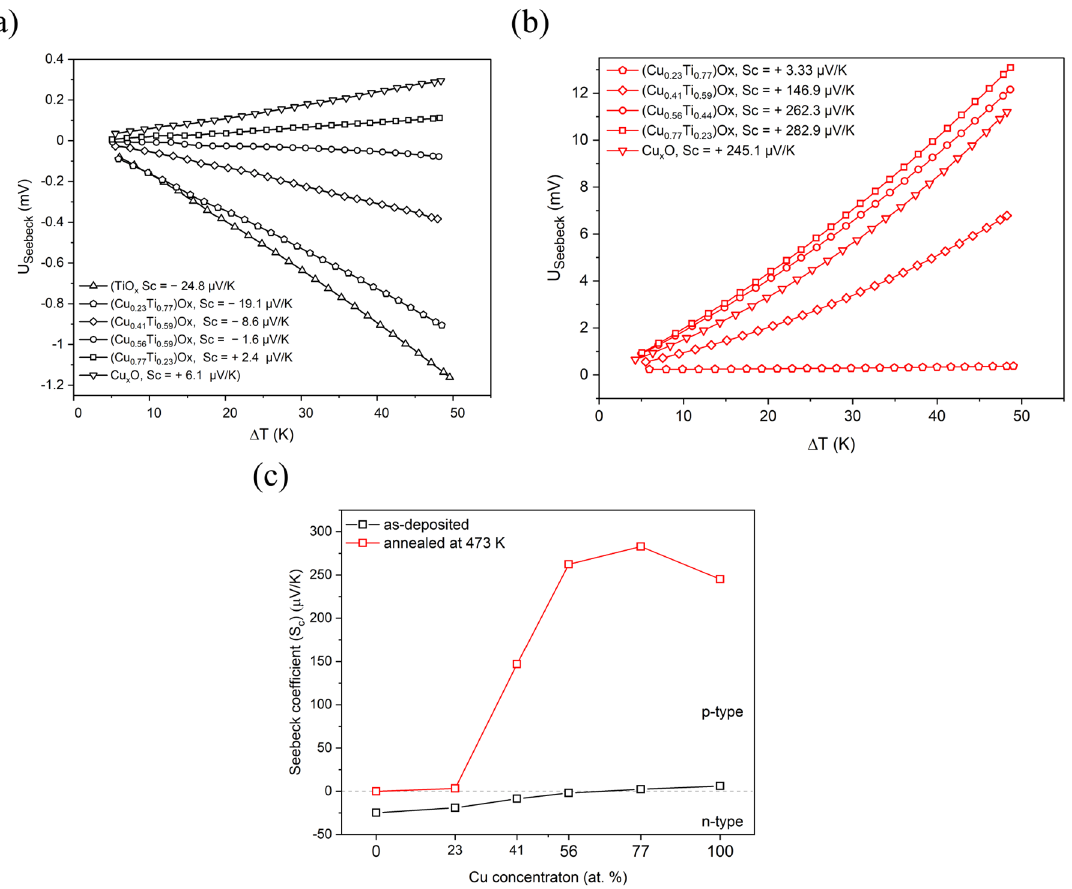
Figure 5. Thermoelectric characteristics of: ( a ) as-deposited, ( b ) annealed at 473 K (CuTi)Ox thin films, and ( c ) Seebeck coefficient changes depending on the elemental composition and annealing of the thin films.